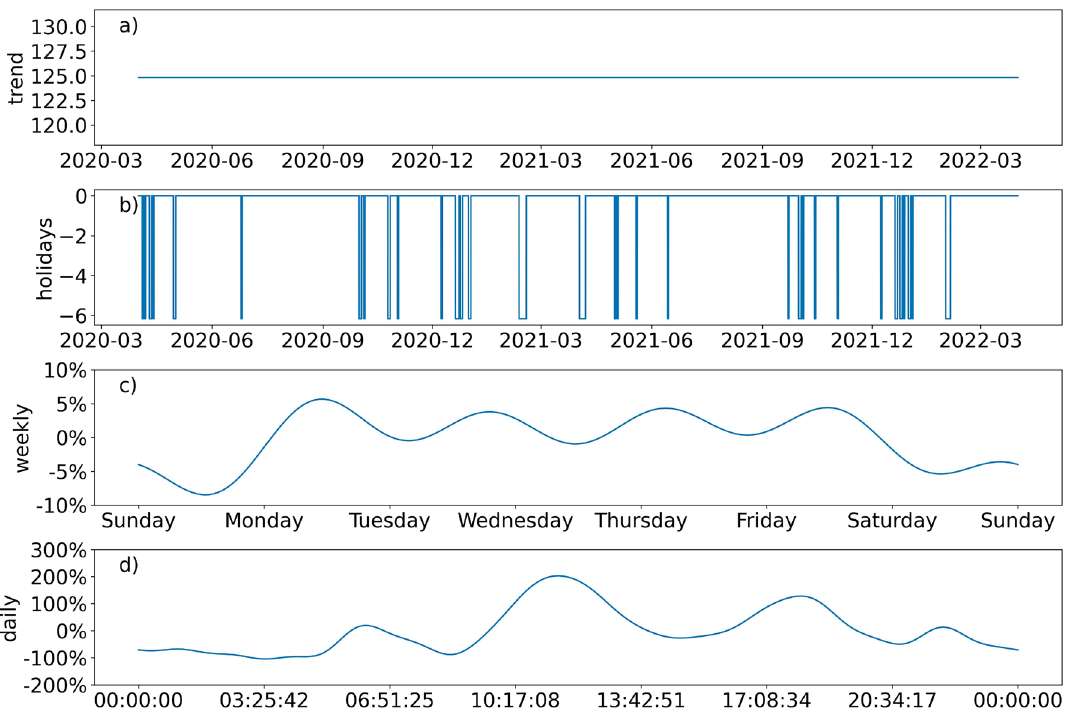
Figure 5. Components of the Prophet model used to fit the dining covers in the staff cafeteria over time. The panels from the top down are: ( a ) the trend (which is flat in this model) gives the base value of the forecast (in units of covers per hour), ( b ) public holiday effects which act to reduce the base value of the forecast, ( c ) and ( d ) weekly and daily seasonalities giving the percentage of the base value needed to add to the final estimate of the forecast.